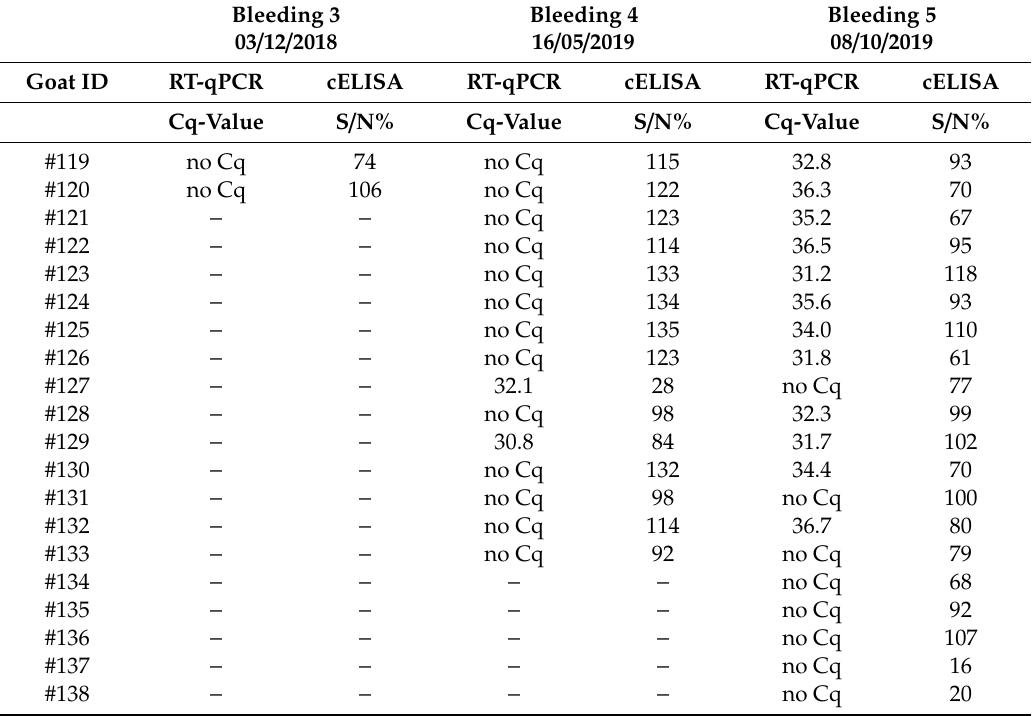
Table 3. BTV-25 specific RT-qPCR and cELISA results of the newly introduced individuals (o ff spring and newly introduced into the farm). Goats were considered positive for BTV-25 specific RT-qPCR with Cq < 40 could be defined. The cut-o ff for the cELISA was 50% and serum samples with an S / N% ≤ 50% were determined as positive (in bold). “ − “represents “no sample available” (not present at that time point in the goat flock).